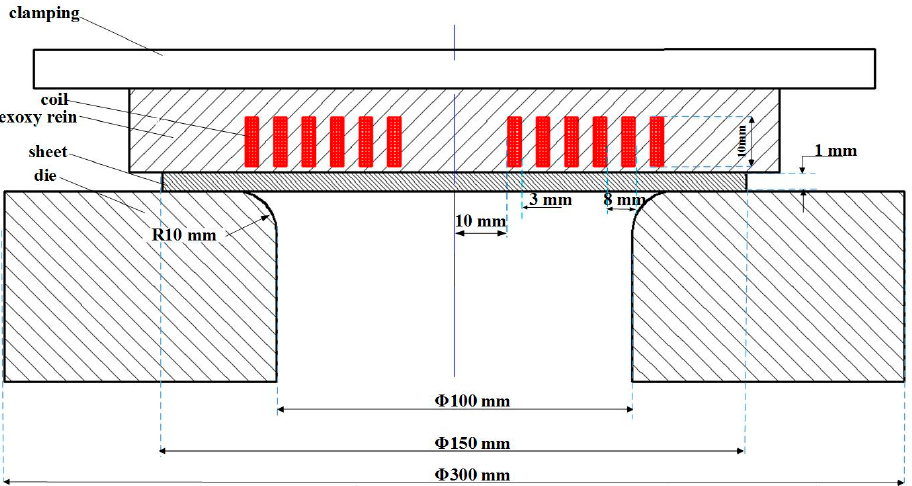
Figure 2. A tool diagram of 5052-O aluminum alloy sheet electromagnetic free forming using the flat spiral coil.